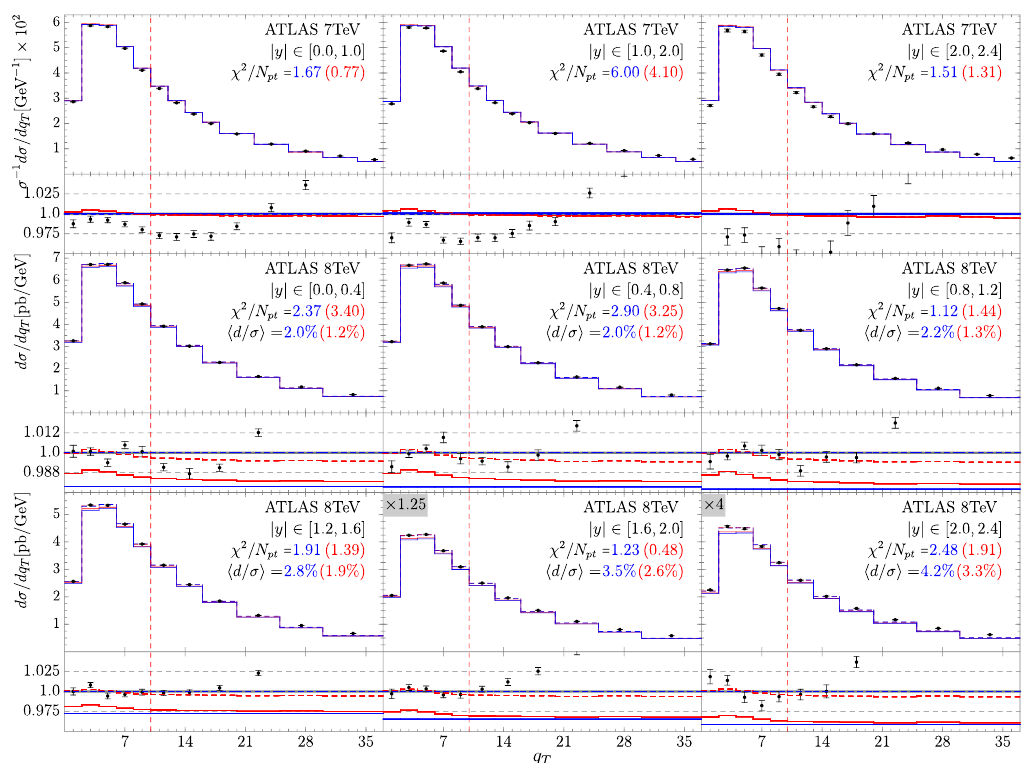
Figure 12 . Di(cid:11)erential cross-section for the Z=(cid:13) (cid:3) boson production measured by ATLAS at di(cid:11)erent values of y and s . The solid lines are absolute prediction. The dashed lines are the theory prediction shifted by h d=(cid:27) i that is indicated on each case together with the values of (cid:31) 2 = np for given data set. Blue (red) color corresponds to the theory prediction at NNLO (N 3 LO). The ratio boxes shows same plot weighted by the shifted theory prediction at NNLO. Vertical dashed lines show the part of the data included in the (cid:12)t (to the left of the